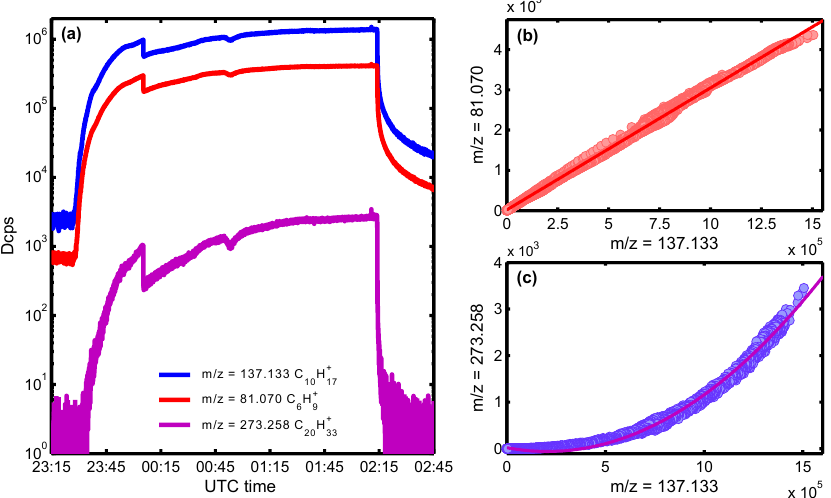
Figure 2. (a) Time series of m/z = 137.133 (C 10 H + experiment (2016). (b) Correlation plot of m/z = 137.133 (C 10 H + m/z = 137.133 (C 10 H +